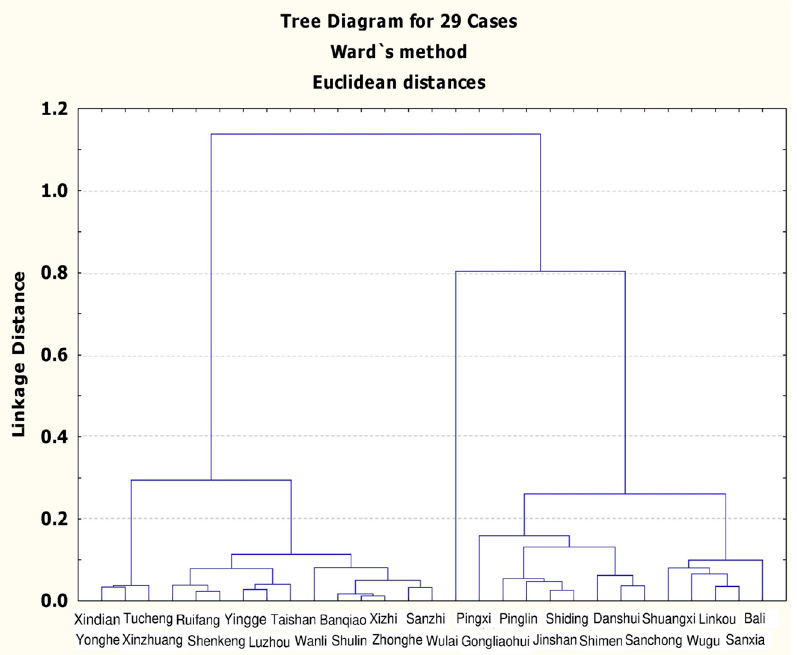
Figure 1. Tree diagram for the results of Ward’s grouping method. Table 2. Analysis results of multivariate analysis of variance (MANOVA).